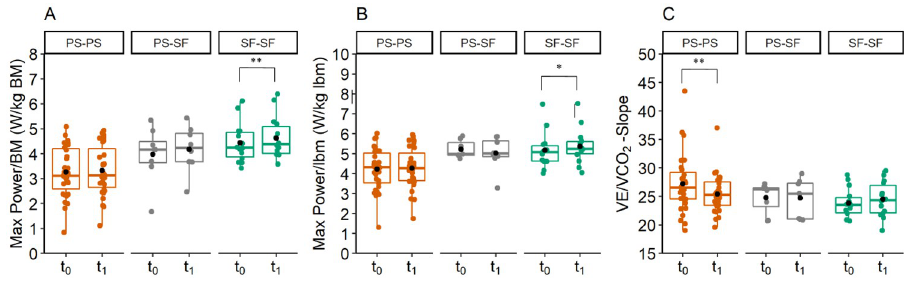
Fig 5. Change of CPET variables over three months. (A) Variable Max Power/BM had in SF-SF (symptom-free– symptom free) significantly higher mean values at t 1 (three months post first examination) than at t 0 (first examination date). (B) Variable Max Power/lbm had in SF-SF significantly higher mean values at t 1 than at t 0 . (C) Variable VE/ VCO 2 -Slope had in PS-PS significantly lower mean values at t 1 than at t 0 . � p < 0.05, �� p < 0.01.